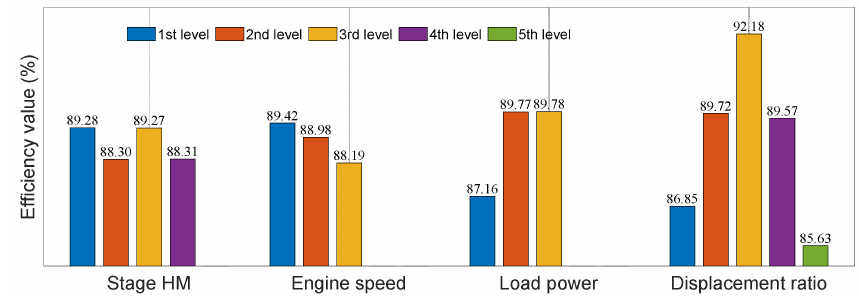
Figure 8. Range calculation